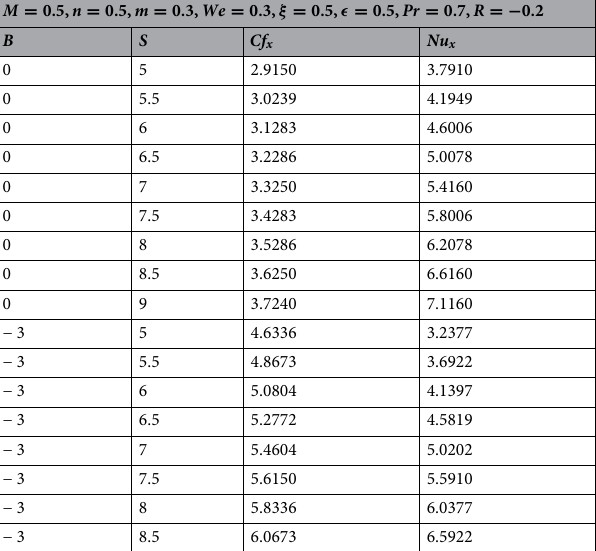
Table 1. Numeric results of skin friction and heat transfer coefficient under influence of stretching ratio and strong mass suction impact.